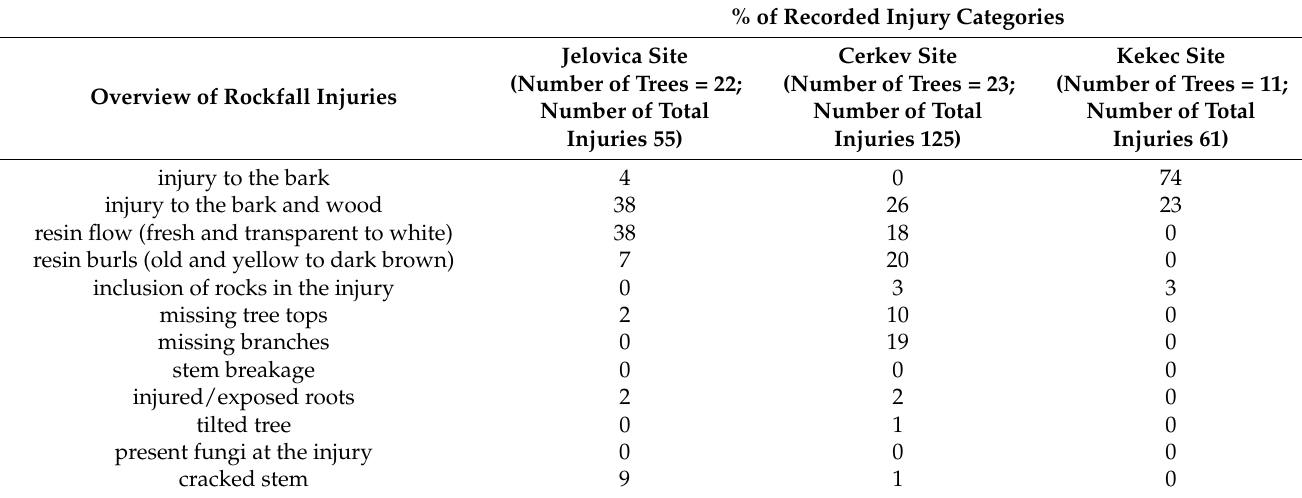
Table 4. An overview of characteristics of rockfall injuries at all three study